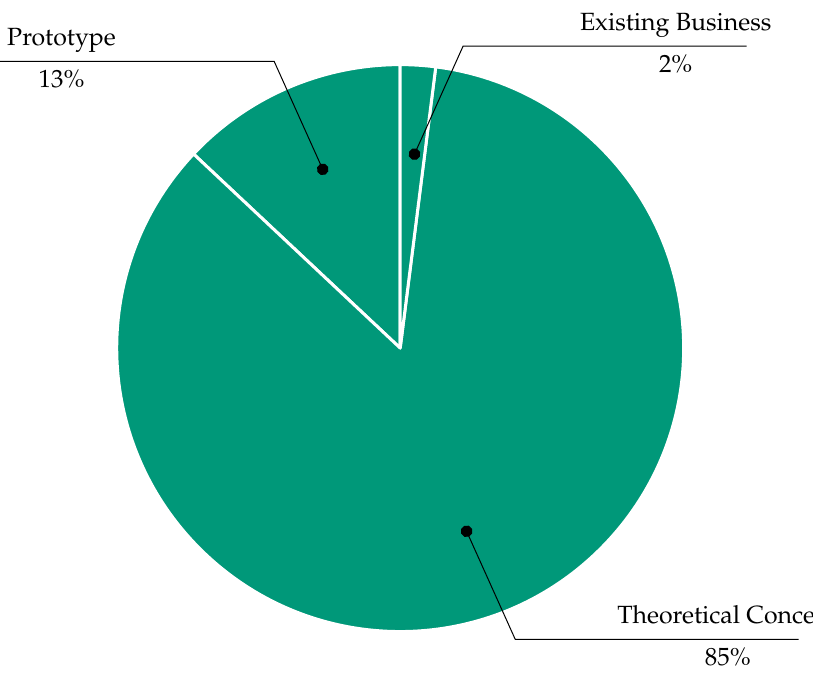
Figure 7. Distribution of maturity categories in literature